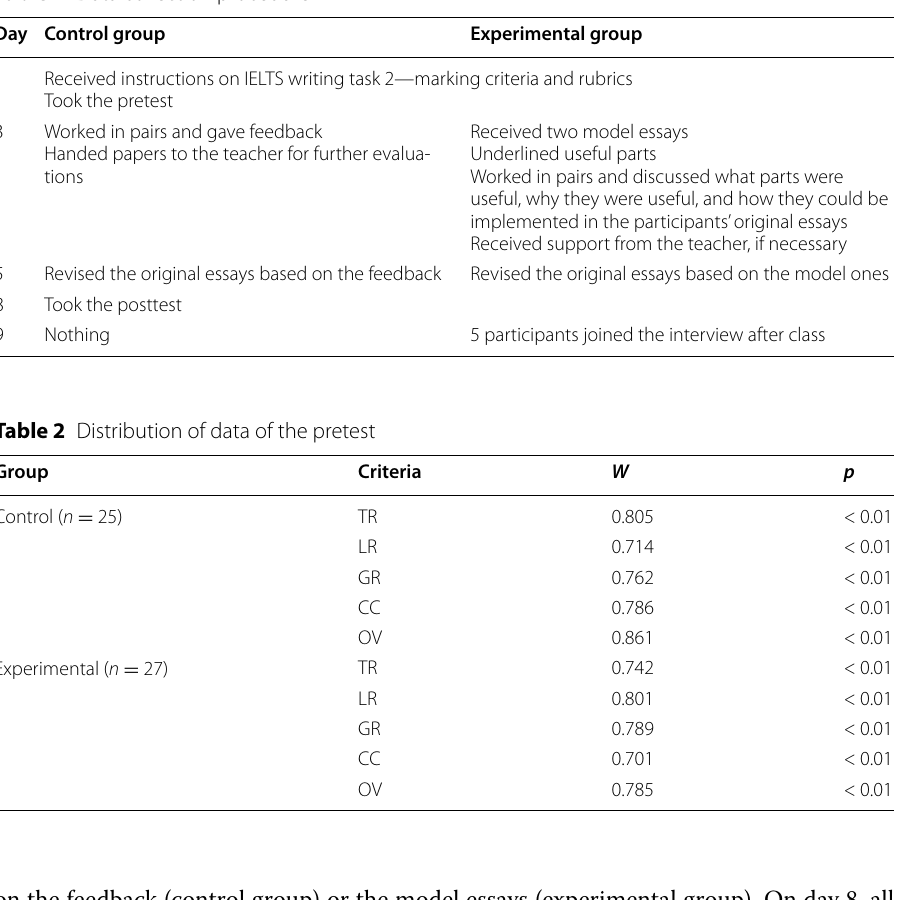
Table 1 Data collection procedure